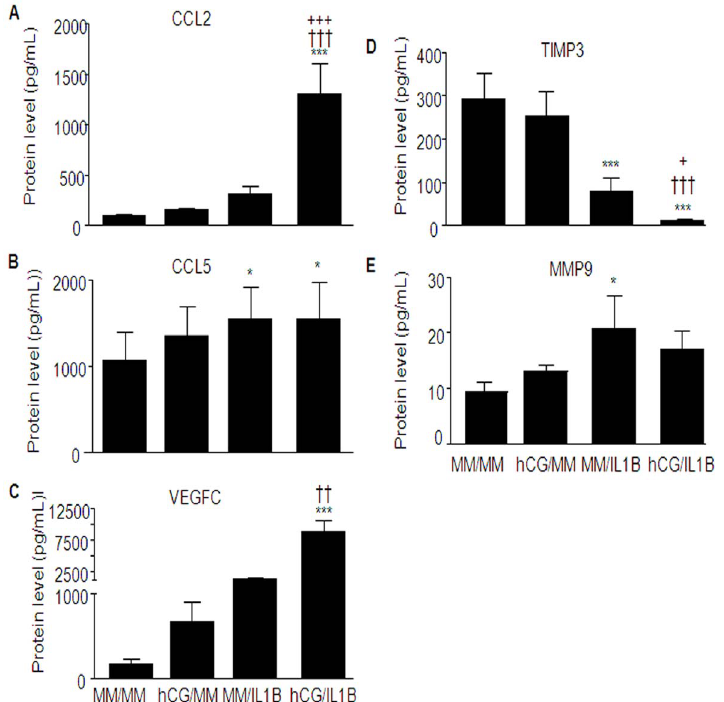
Figure 6. hCG modulates the expression of immune, angiogenic and tissue remodeling factors in ESCs at the protein level. Confluent ESC cultures were incubated with minimal medium (MM) or hCG (100 ng/mL) for 24 h before being exposed or not to IL1B (0.1 ng/mL) for additional 24 h. Supernatant was collected and soluble proteins CCL2 (A) CCL5 (B) VEGFC (C) TIMP3 (D) MMP9 (E) were then quantified by ELISA. Data were from ESC cultures issued from 4 different subjects and expressed in pg/mL. *P , 0.05, *** P , 0.001 relative to MM; {{ P , 0.01, {{{ P , 0.001 relative to cells stimulated with an equivalent concentration of hCG; + P , 0.05, +++ P , 0.001 relative to cells stimulated with an equivalent concentration of IL1B. doi:10.1371/journal.pone.0064829.g006 PLOS ONE |